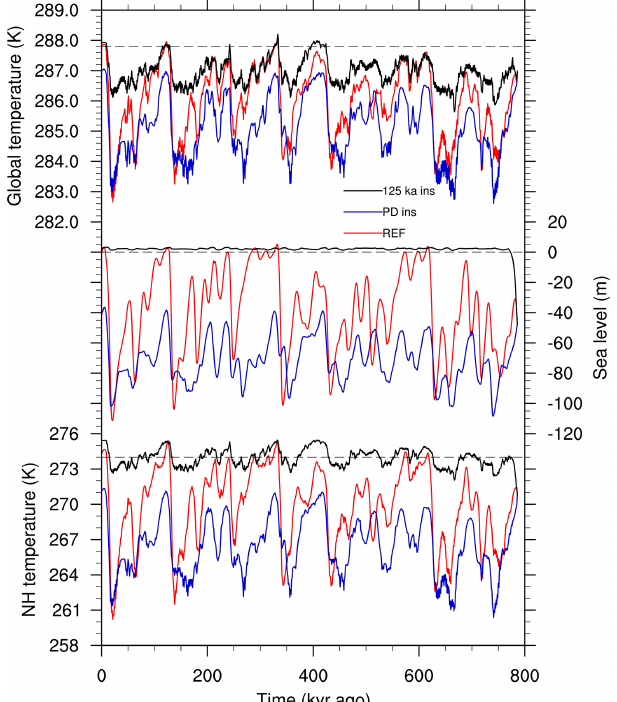
Figure 12. Modelled global temperature (top), sea level relative to PD (middle) and NH temperature (bottom) for the fully coupled reference run (red), a run with CO 2 fixed at 180ppm (full glacial value, blue), a run with CO 2 fixed at 230ppm (intermediate value, black), and CO 2 fixed at 280ppm (interglacial (PI) value,